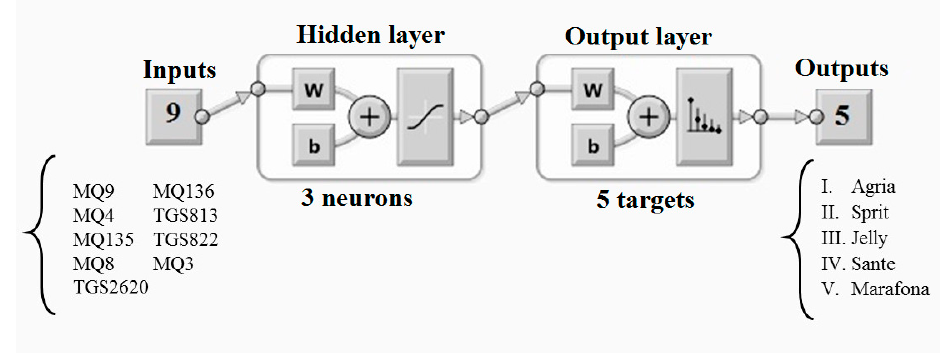
Figure 2. Diagrams of the two-layer feedforward models with a tan-sigmoid function in the hidden layer and a Softmax function in the output layer for electronic nose inputs. Abbreviations: W: weights; b: bias. Adapted from ref. [32].